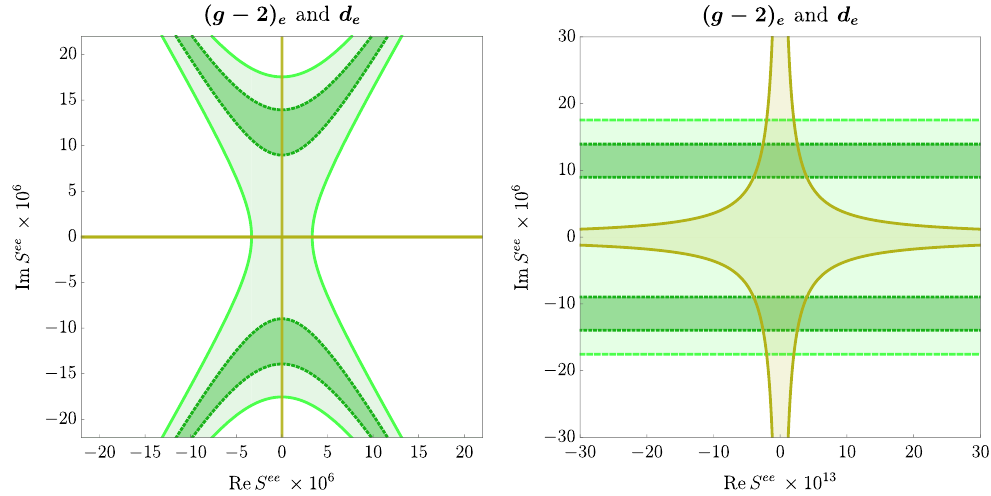
Figure 11 . Favored region for the diagonal coupling S ee , due to the electron anomalous magnetic and electric dipole moments. Within the light (dark) green region, the deviation in the electron AMM is explained at the 3 σ ( 1 σ ) level. The region delimited by the orange continuous lines is the parameter space allowed by the current experimental upper bound of the electron EDM. In the figure on the right, the abscissa axis has been zoomed.